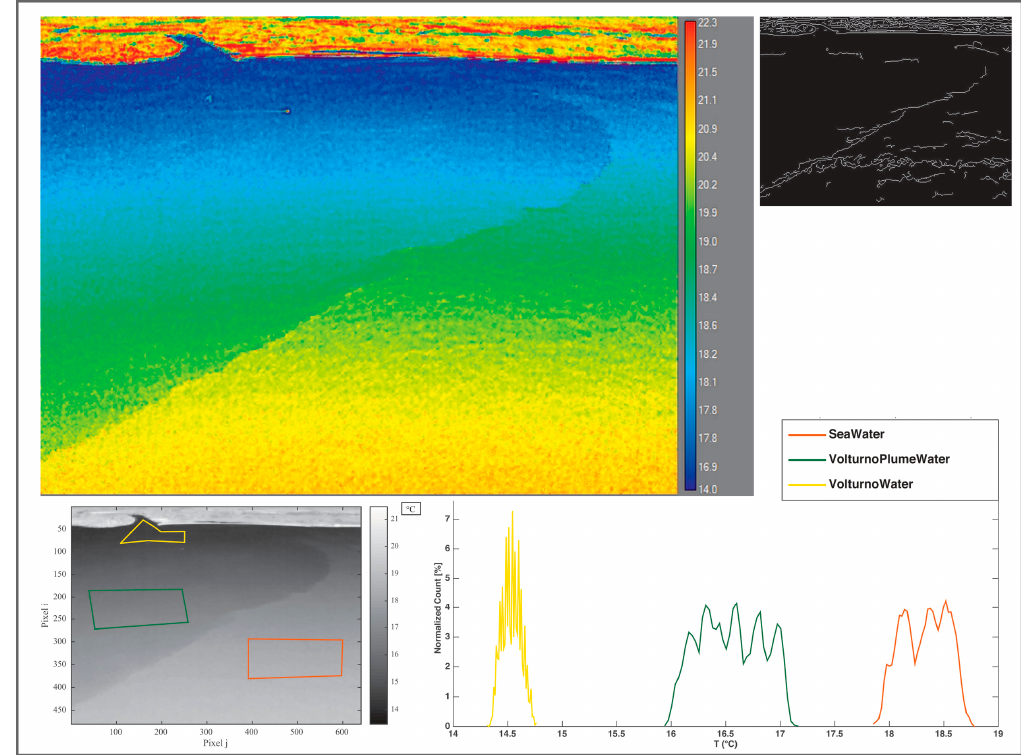
Figure 4. Thermal image of the Volturno plume with polygons over the channel, seawater, and plume areas of interest, which correspond to histograms of radiometric temperature; and (upper right side) edges of the Volturno channel plume as white lines to the right of the image.